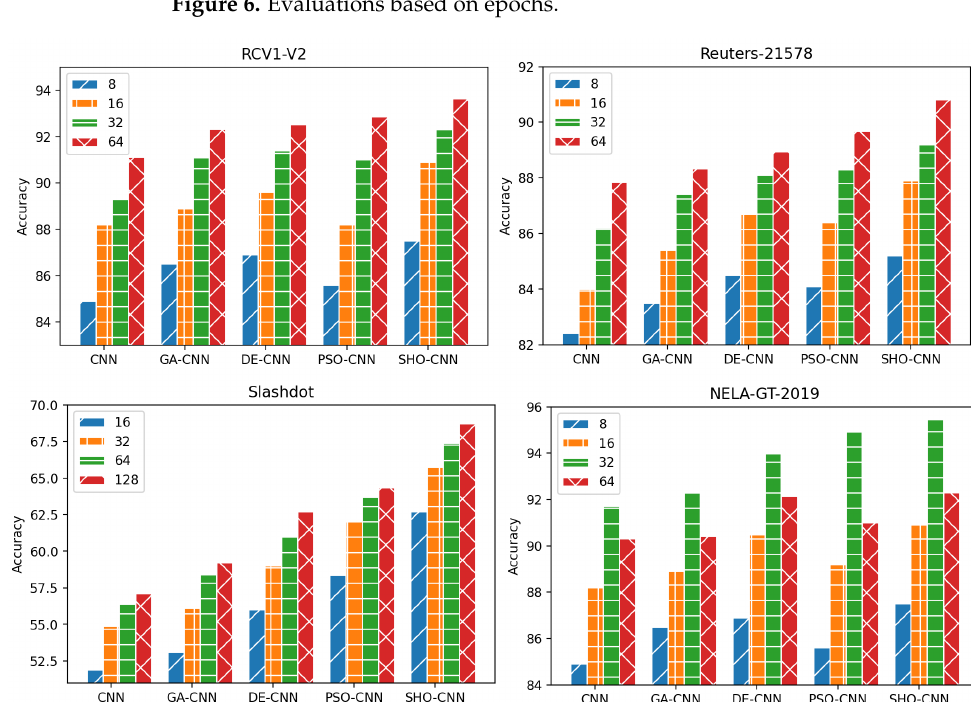
Figure 7. Evaluations based on batch